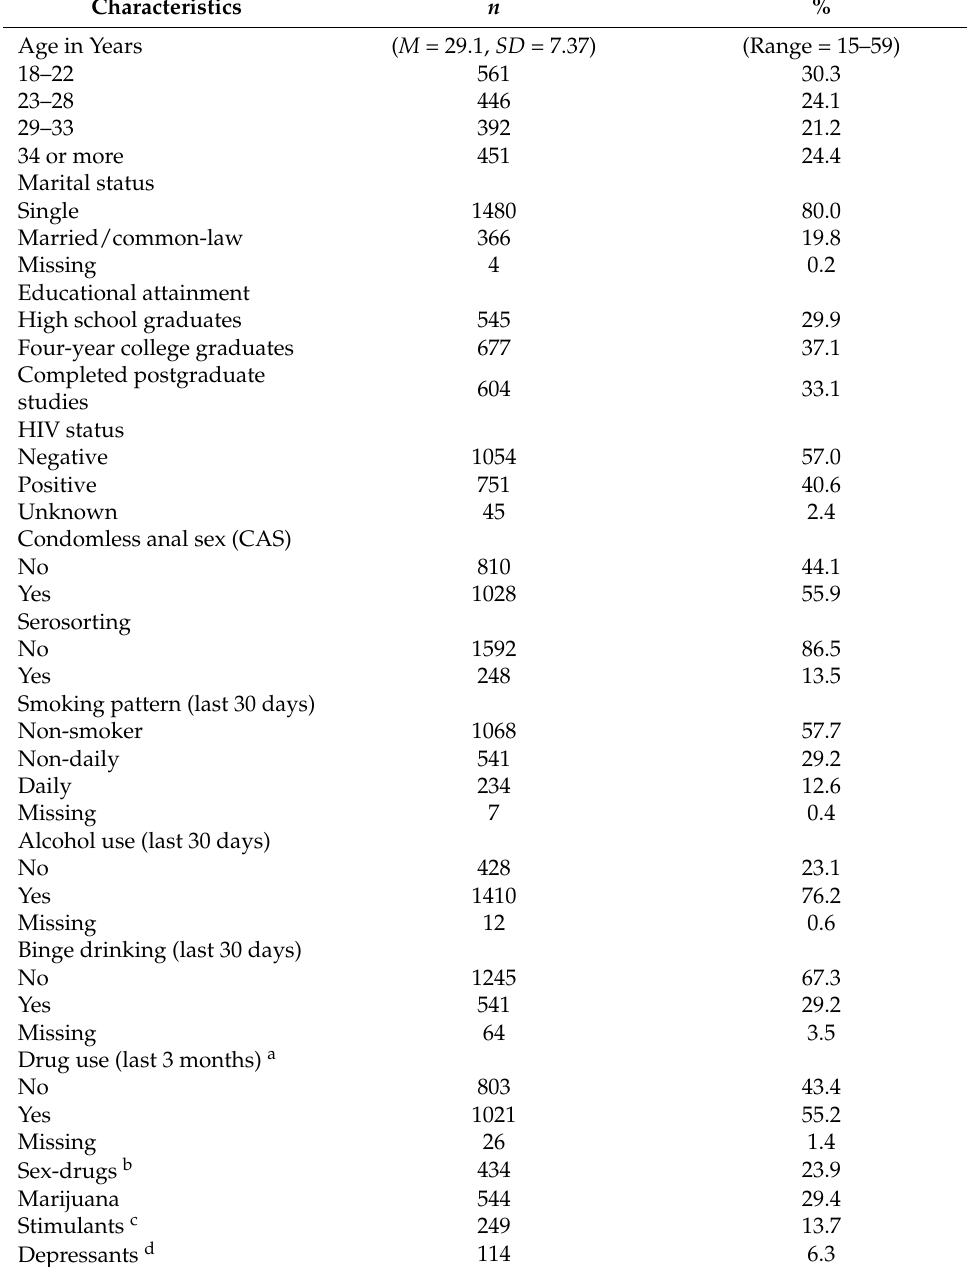
Table 2. Characteristic demographics, HIV status, sexual behavior, tobacco use, alcohol use, and drug use of 1850 MSM visiting HIV clinics in Mexico City,